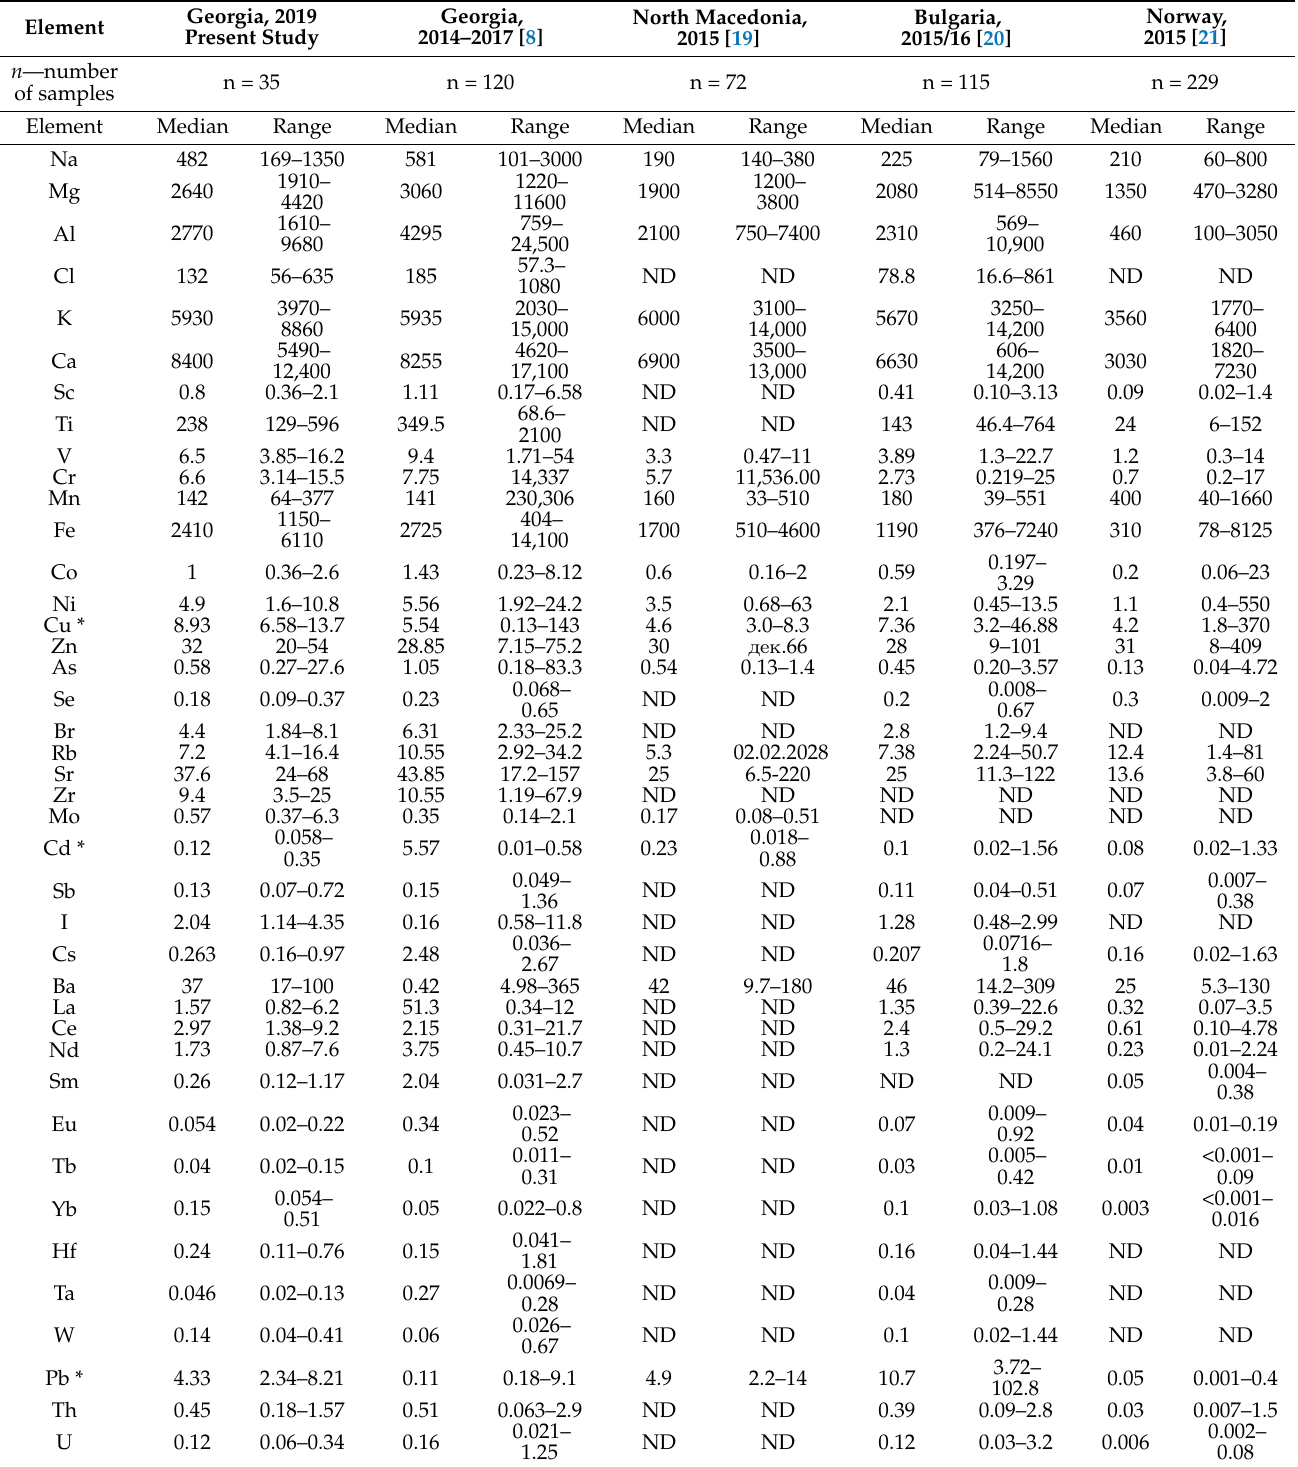
Table 3. Comparison of the results obtained in present study with the countries allocated in relatively the same geographical belt. Norway chosen as a pristine area. Concentration is in